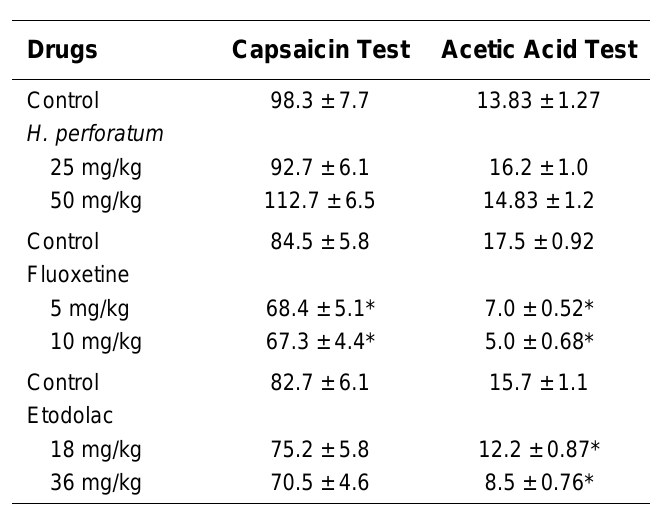
Effect of H. perforatum , Fluoxetine, and Etodolac on Duration of Capsaicin-Induced Paw Licking and Number of Writhes in the Acetic Acid Test in